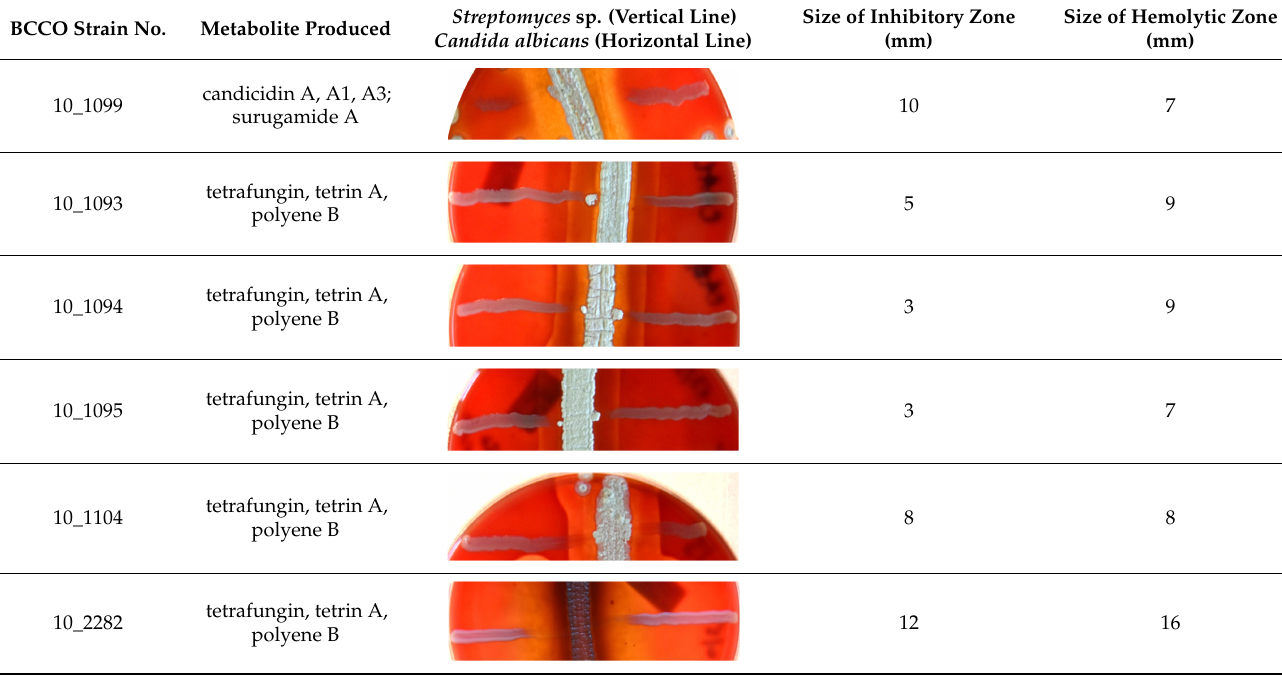
Table 3. Inhibitory activity of Streptomyces spp. against Candida albicans . BCCO Strain No.